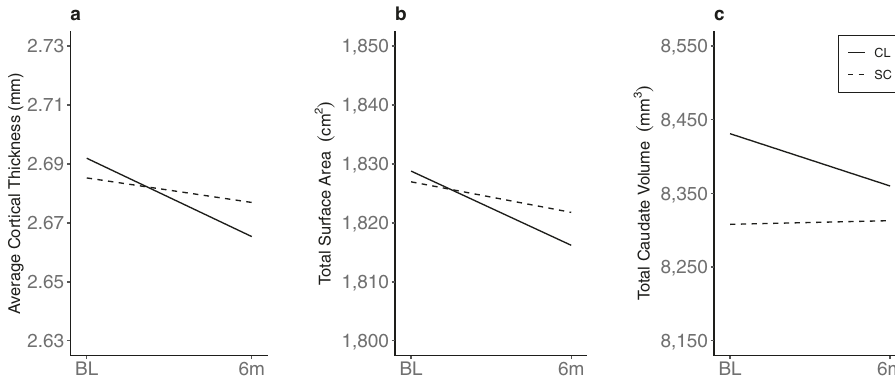
Fig. 1 | Group differencesinbrain structure overtime. Trajectories for ( a ) averagecortical thickness (mm),( b ) totalsurface area (cm2), and ( c ) caudate volume(mm3) are shown for Closed Loop (CL) and Standard Care (SC) groups.